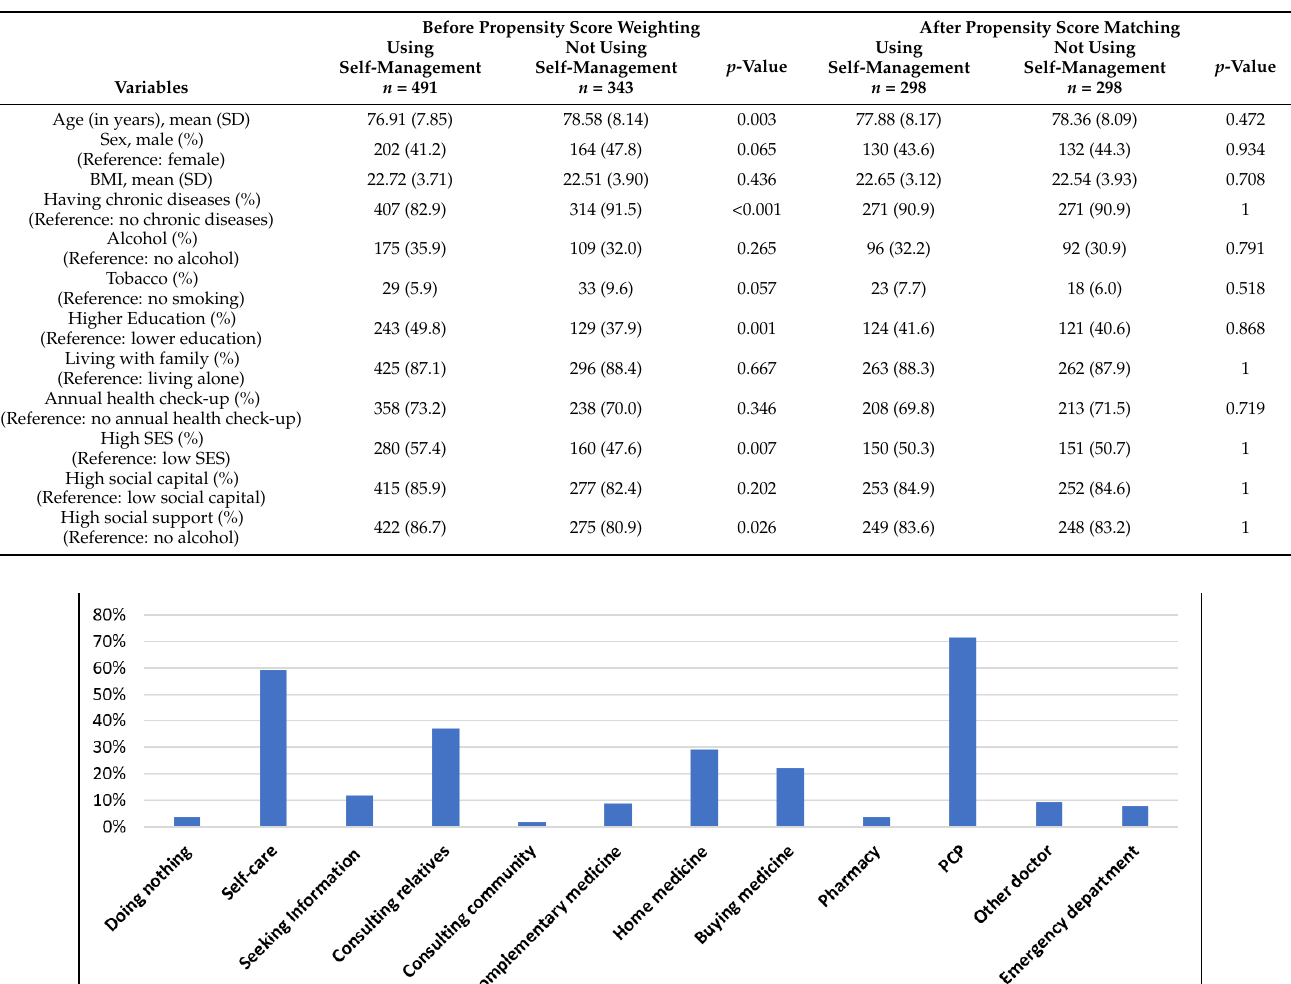
Table 1. Demographic data of the participants in each group and the significance level of the comparison among the two groups before and after propensity score matching.